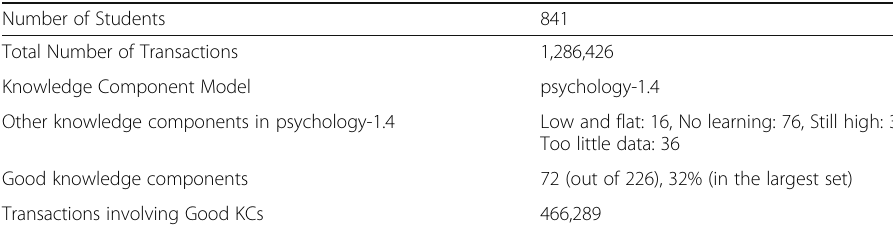
Table 10 Psychology course data